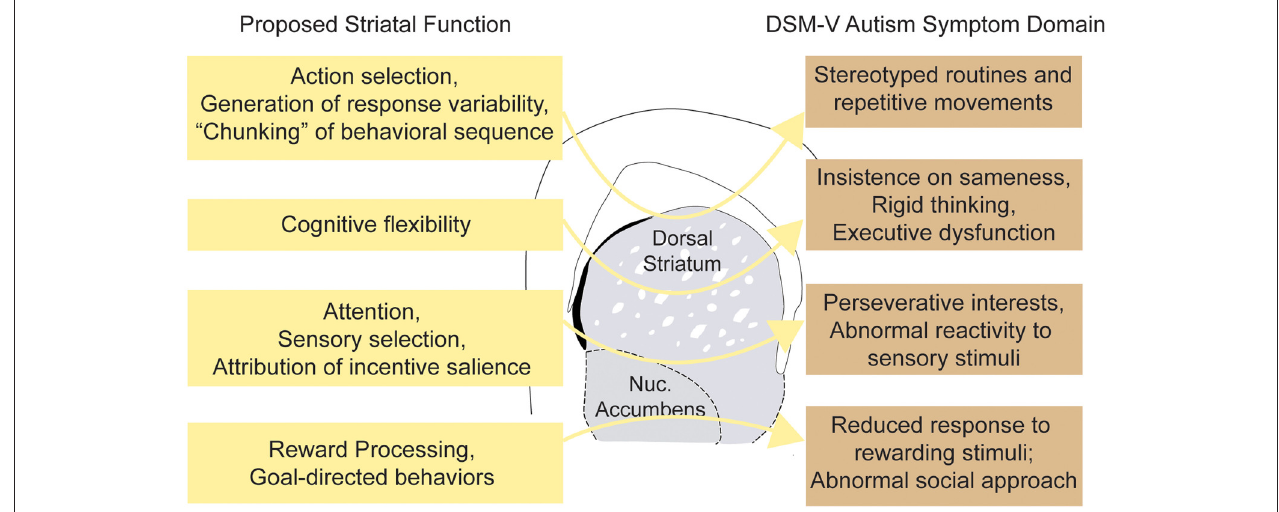
FIGURE 2 | Striatal dysfunction and major autism spectrum disorder symptom domains. Schematic illustrating hypothetical connections between abnormalities of striatal function and the varied clinical phenotypes observed in